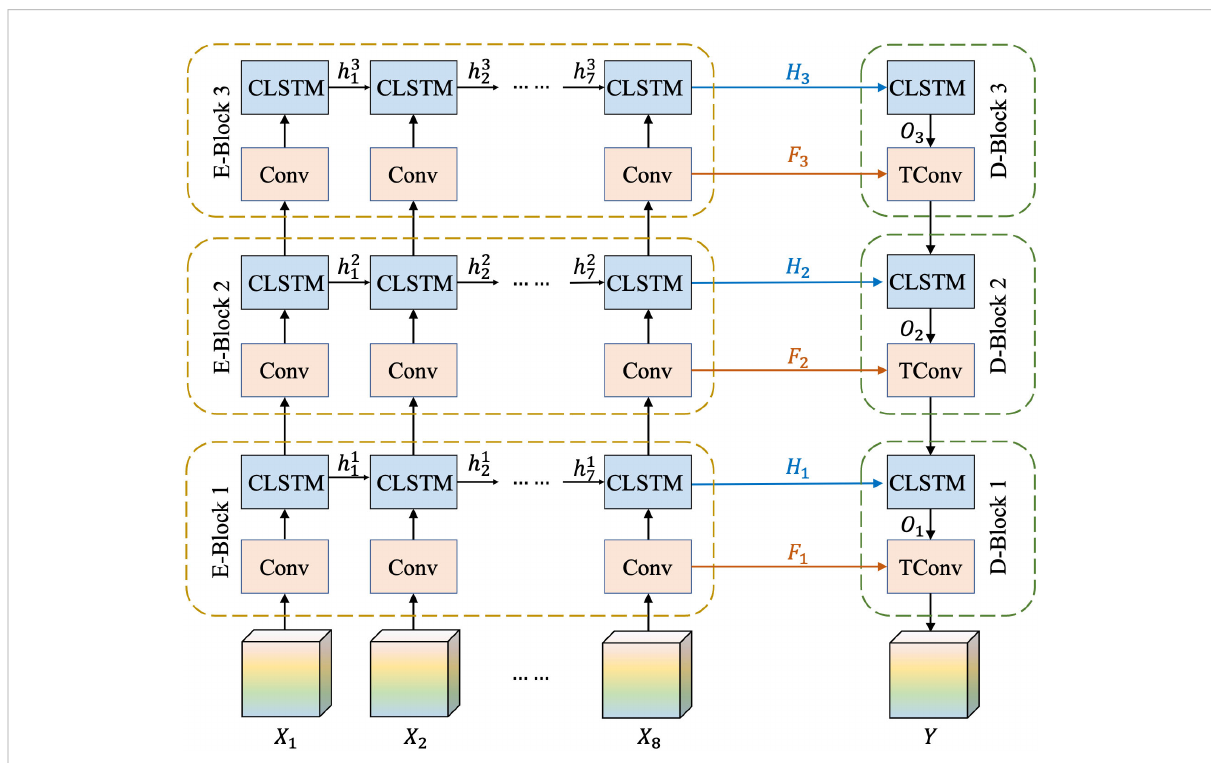
FIGURE 6 Inner structure of feature fusion module, including multi-scale spatiotemporal feature capturing and same-stage feature